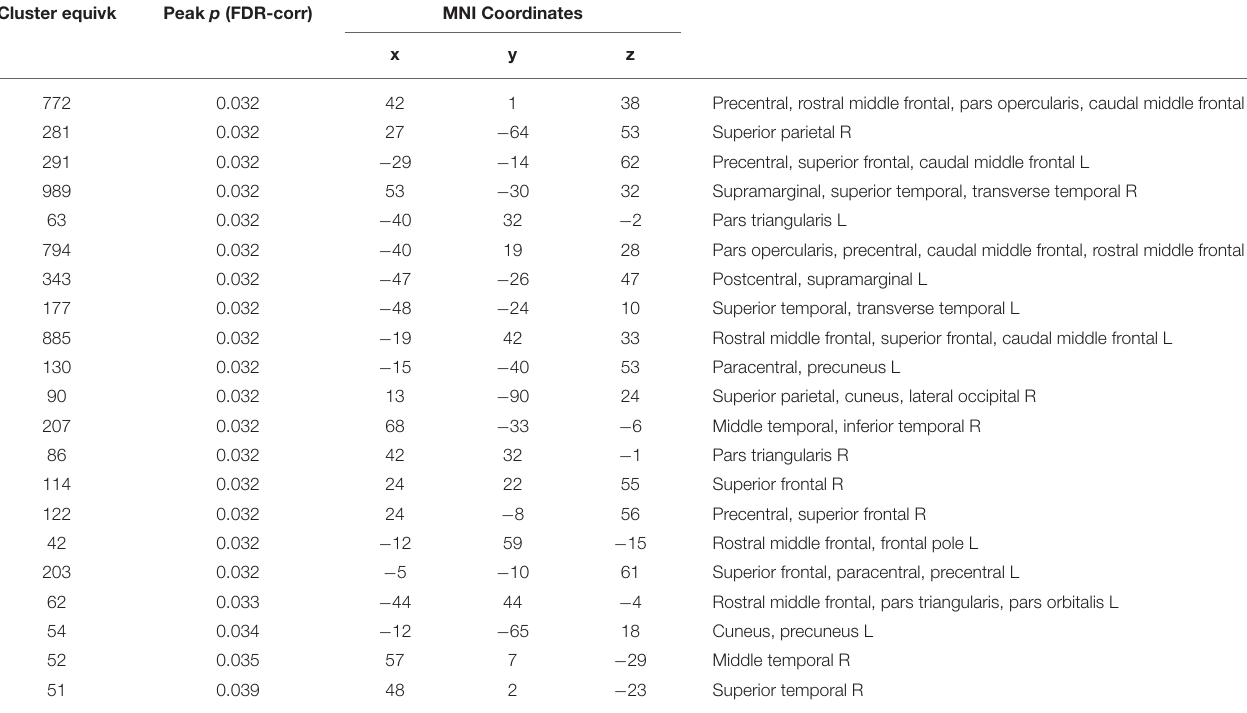
TABLE 3 | Regional brain differences in morphometric profiles between HC and EO-OABD patients. Cluster equivk Peak p (FDR-corr)